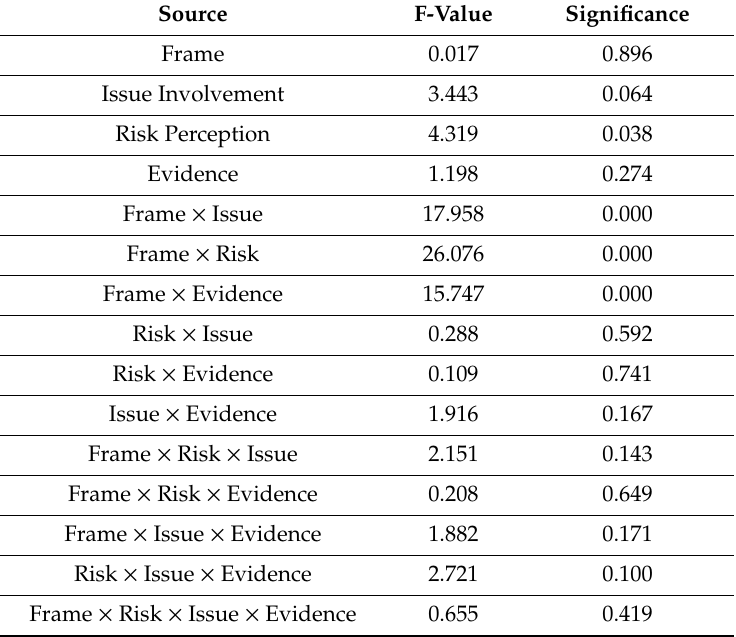
Table A1. Results of